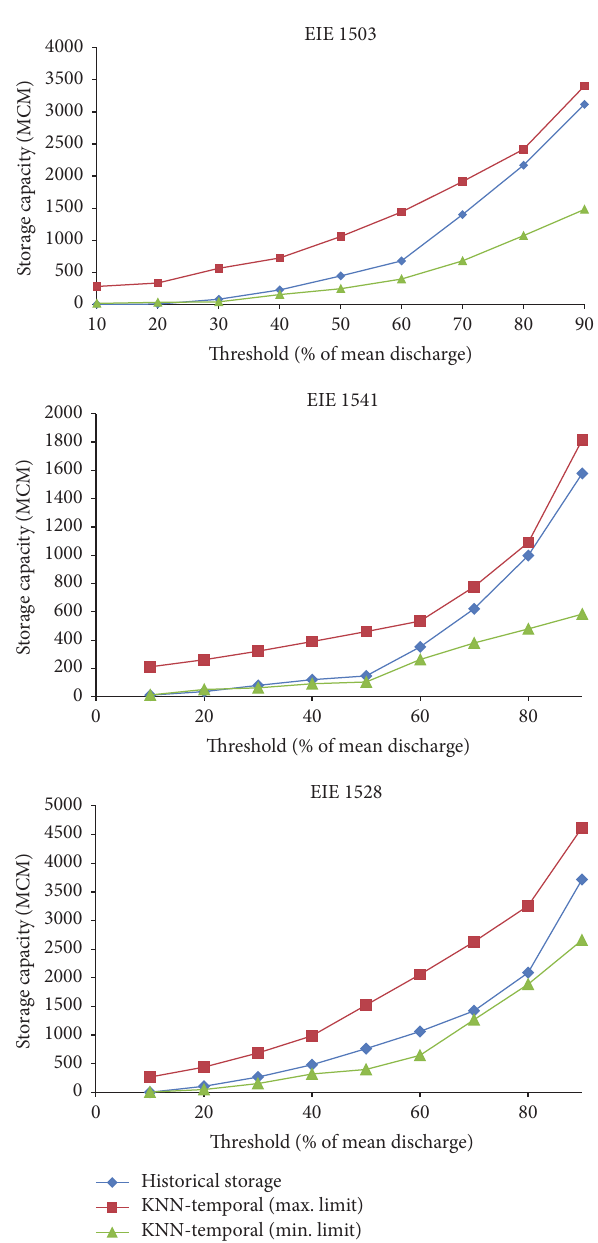
Figure 7: Monthly historical storage capacity and their limits calculated from the temporal approach at all stations.